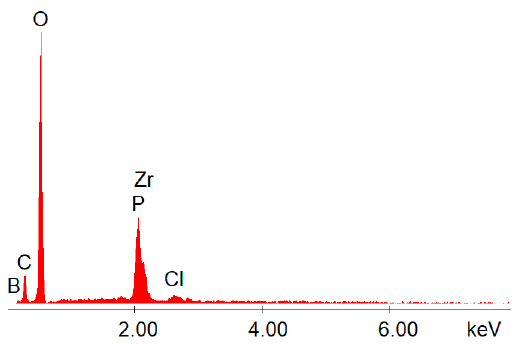
Figure 3. EDX data for the hybrid compound S3 .